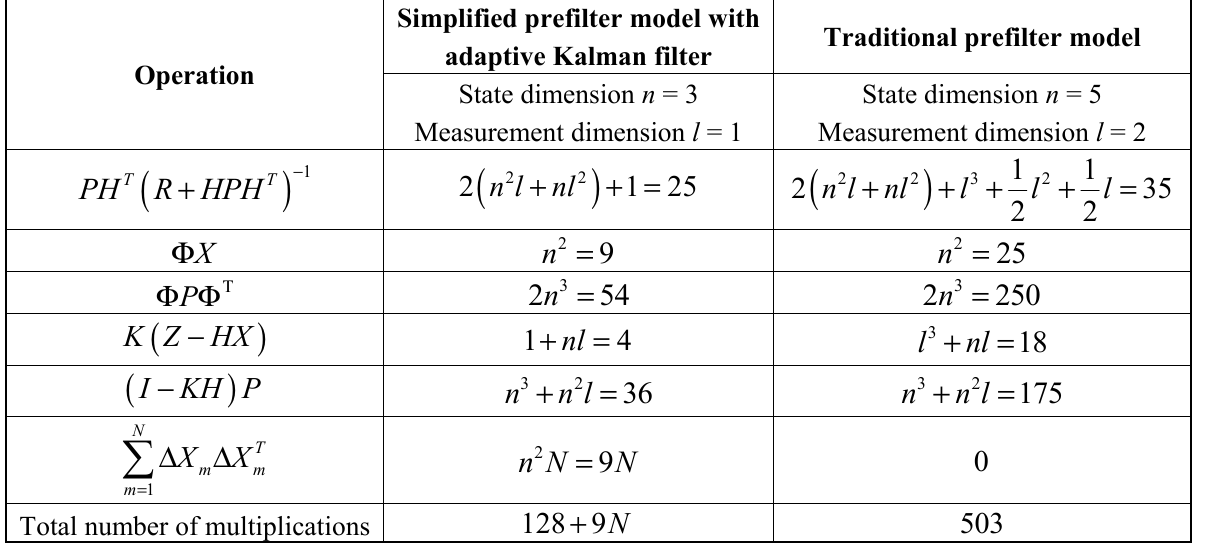
Table 1. Computational Complexities of Kalman filter